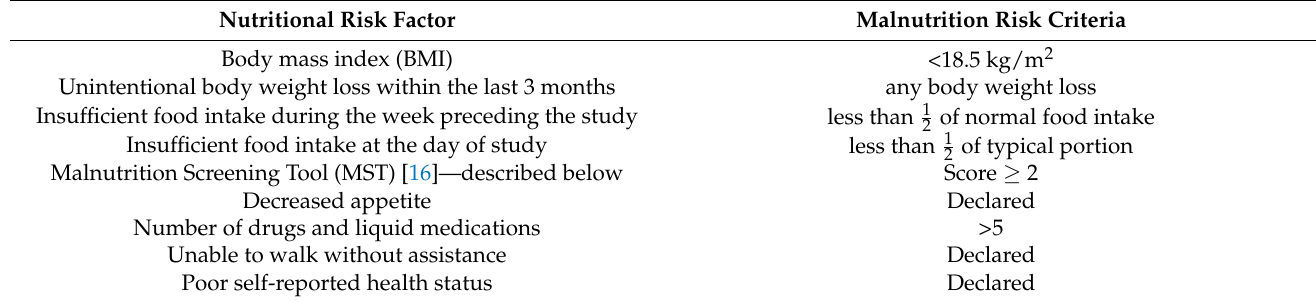
Table 1. Criteria used to determine the prevalence of nutritional risk factors.